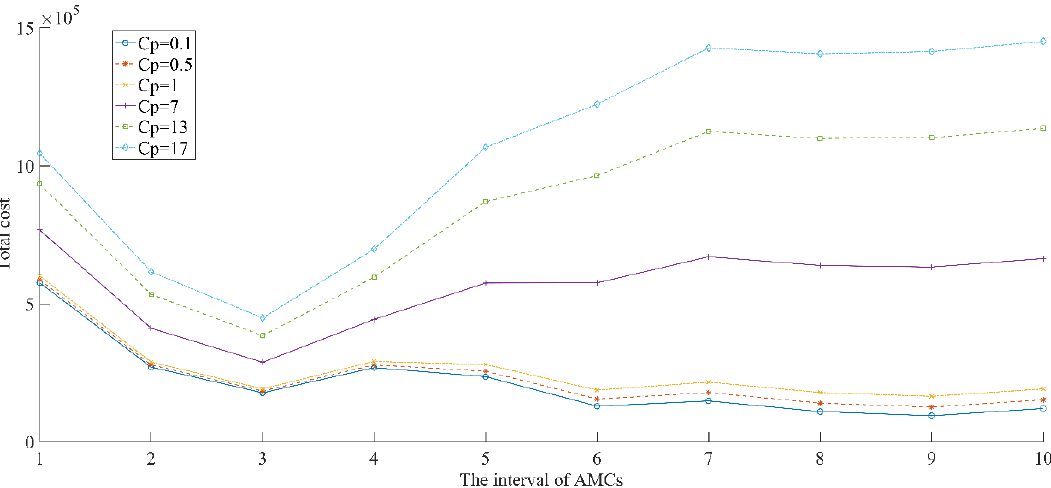
Figure 10. Expected total cost C vs. A for Figure 10. Expectedtotalcost C vs. A for M m = 10 6 , M m = 10 4 , r = 0.5, α = 1, β = 0.01, C